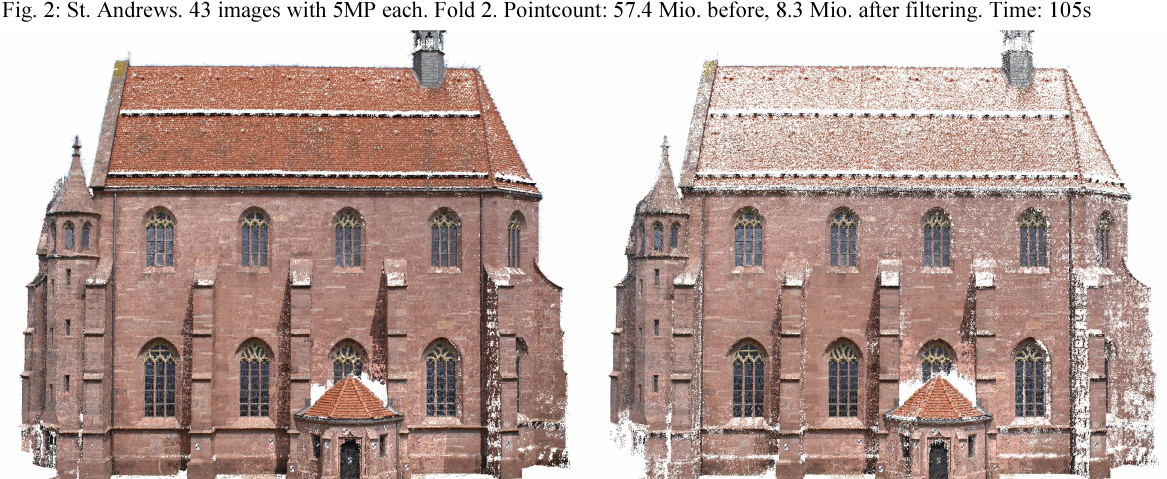
Fig. 3: Lady chapel. 73 images with 12MP each. Left: Fold 2, Right: Fold 3. Pointcount: 311 Mio. before, 47.6 Mio. after filtering with fold 2, 15.8 Mio. after filtering with fold 3. Time: ~20 Minutes (no SSD). Dataset: [Moussa et al.,